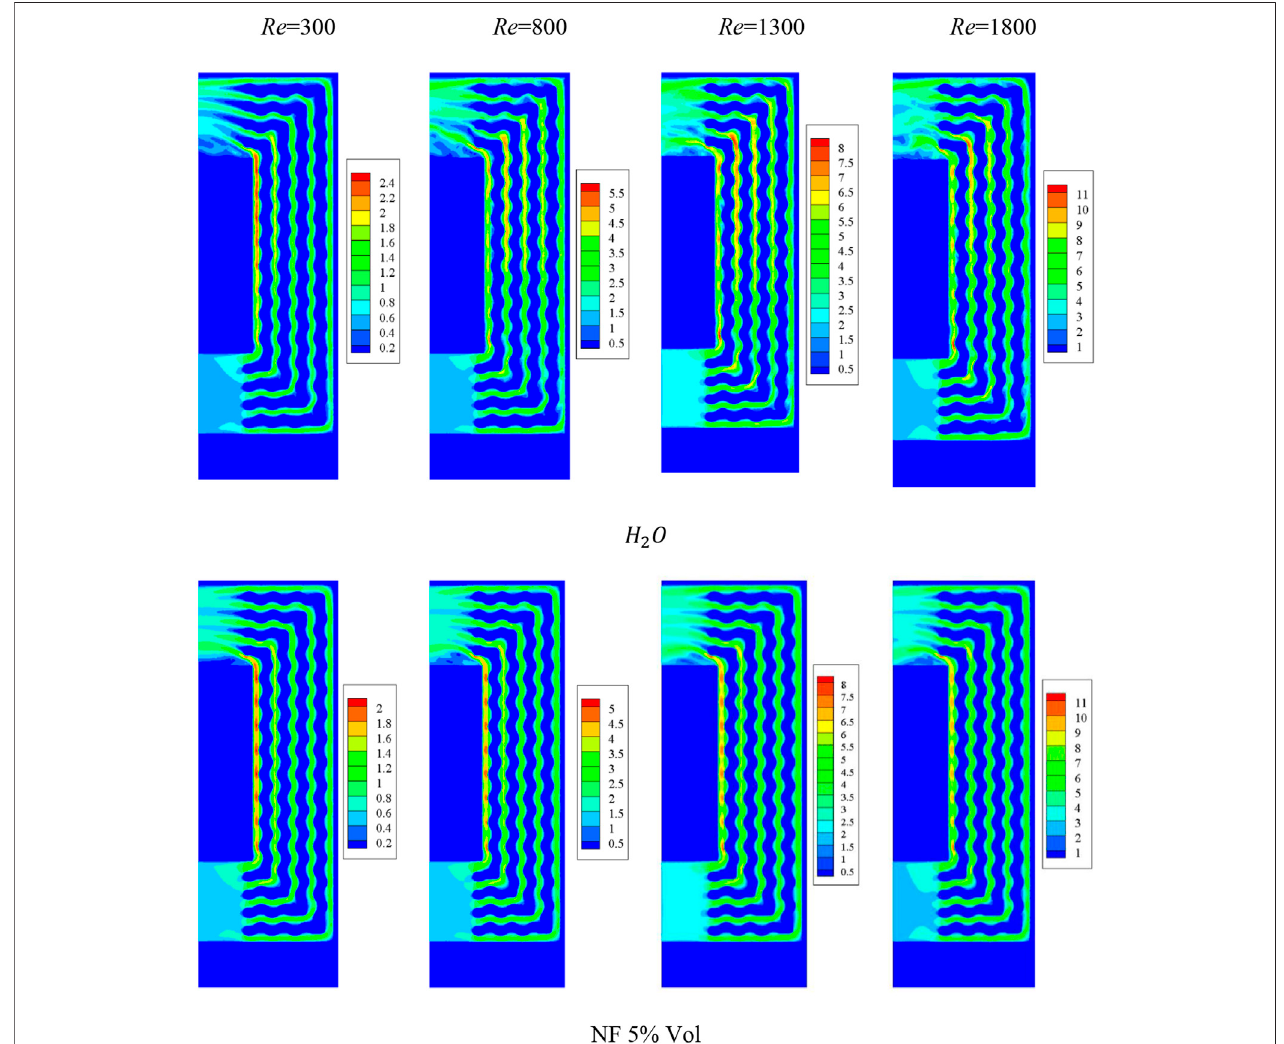
FIGURE 4 | Velocity contours on the middle plane of the H-S for various amounts of Re for water/ Al 2 O 3 with φ (cid:1) 5%.